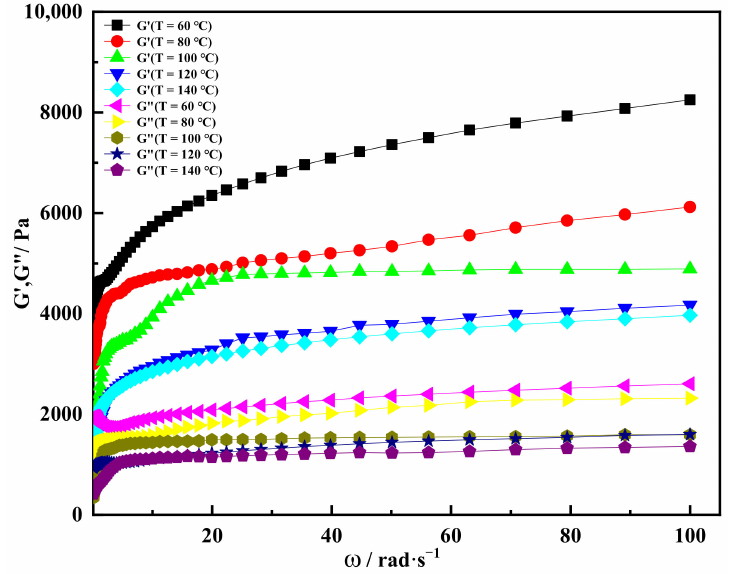
Figure 9. Storage modulus and loss modulus varied with angular frequency under different tempera- ture conditions.